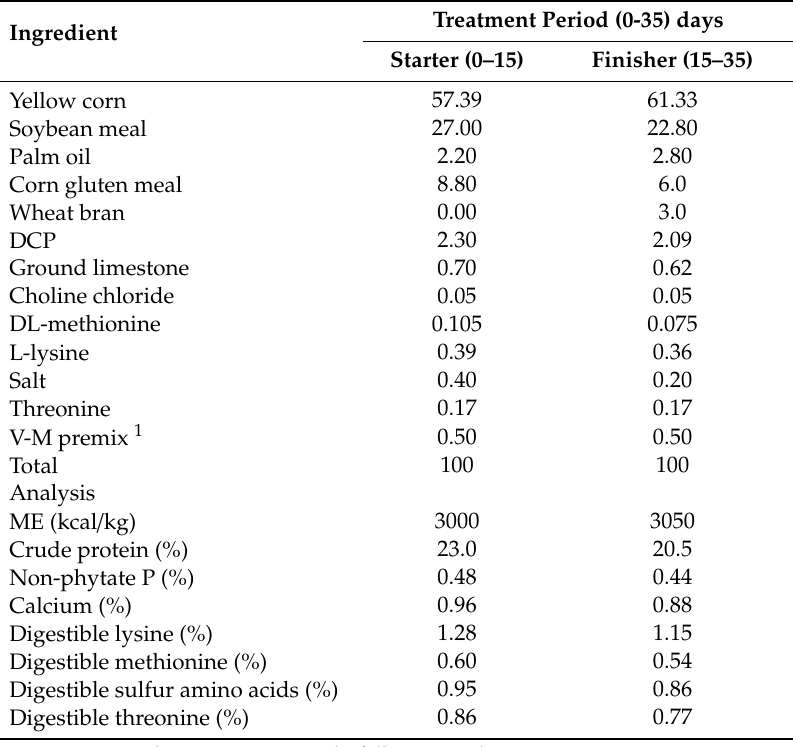
Table 2. Composition of starter and finisher